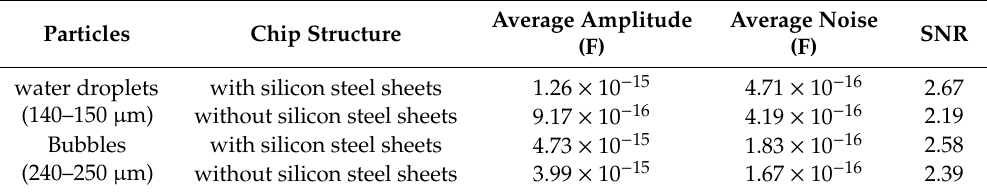
Table 1. Capacitance detection results of double solenoid